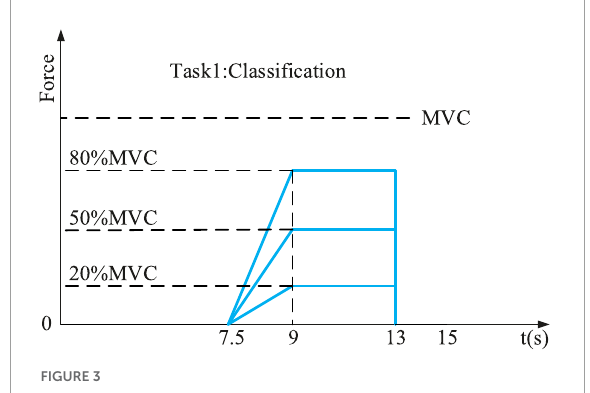
FIGURE3 Three profiles to apply force in the first experiment. Blue lines represent the target force